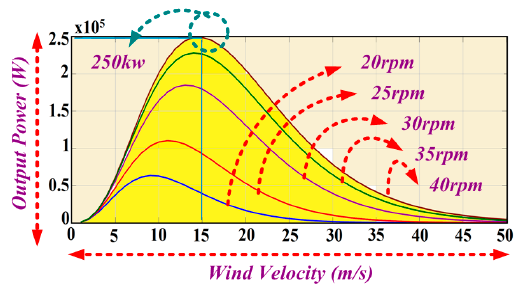
Figure 6. Wind Turbine Power Output vs. Wind Velocity (Wind Speed).